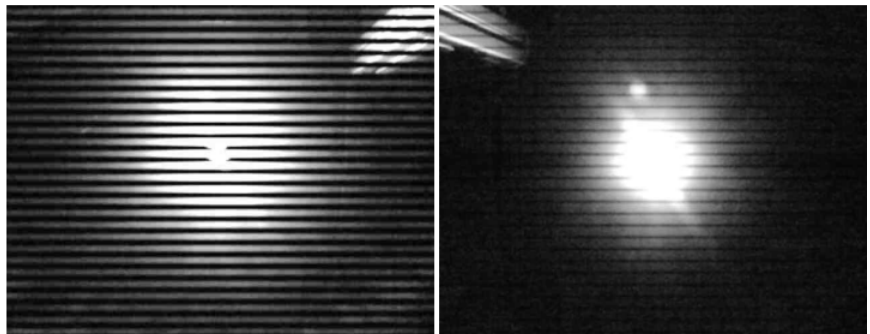
Figure 7. Comparison of 2 kHz square wave ( left ) and sine wave ( right ).